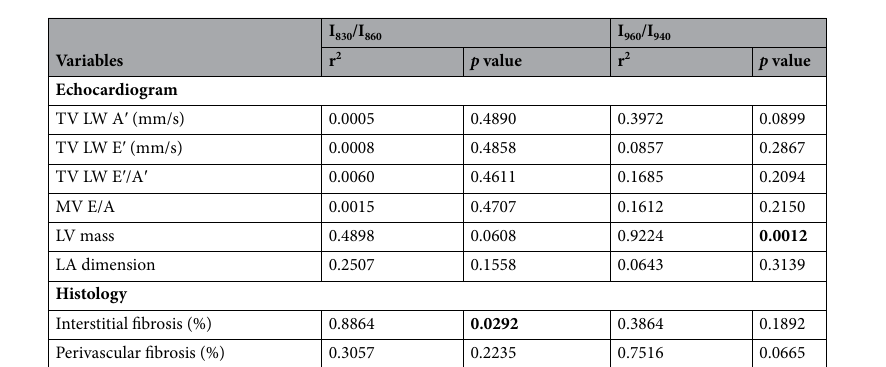
Table 2. Pearson correlation coefficients (r 2 ) and p values for the relation of Raman/FTIR spectral bands (I 830 / I 860 and I 960 /I 940 ) with cardiac functional and structural measurements. TV LW A ′ , peak velocity of diastolic mitral annular motion as determined by pulsed wave Doppler; TV LW E ′ , peak velocity of early diastolic mitral annular motion as determined by pulsed wave Doppler; TV LW E ′ /A ′ , ratio of E ′ to A ′ ; LV mass, left ventricle mass; MV E/A, mitral inflow velocity ratio of E to A; LA dimension, left atrium dimension.